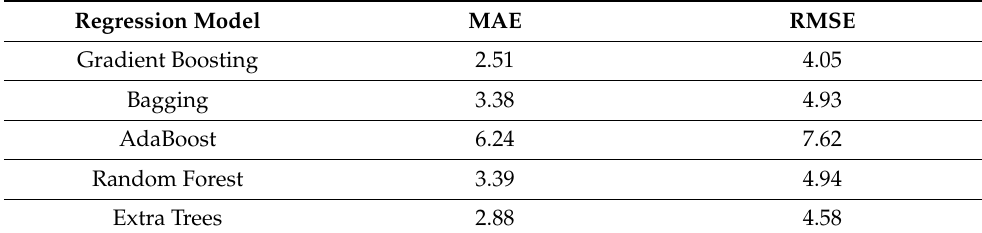
Table 3. Mean Absolute Error (MAE) and Root Mean Squared Error